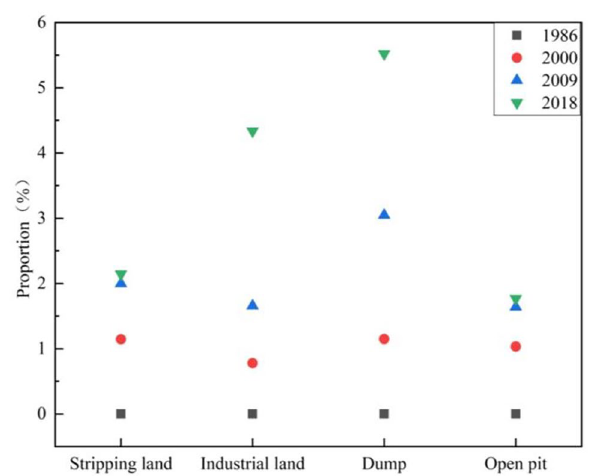
Fig. 3 Proportion of damaged land area